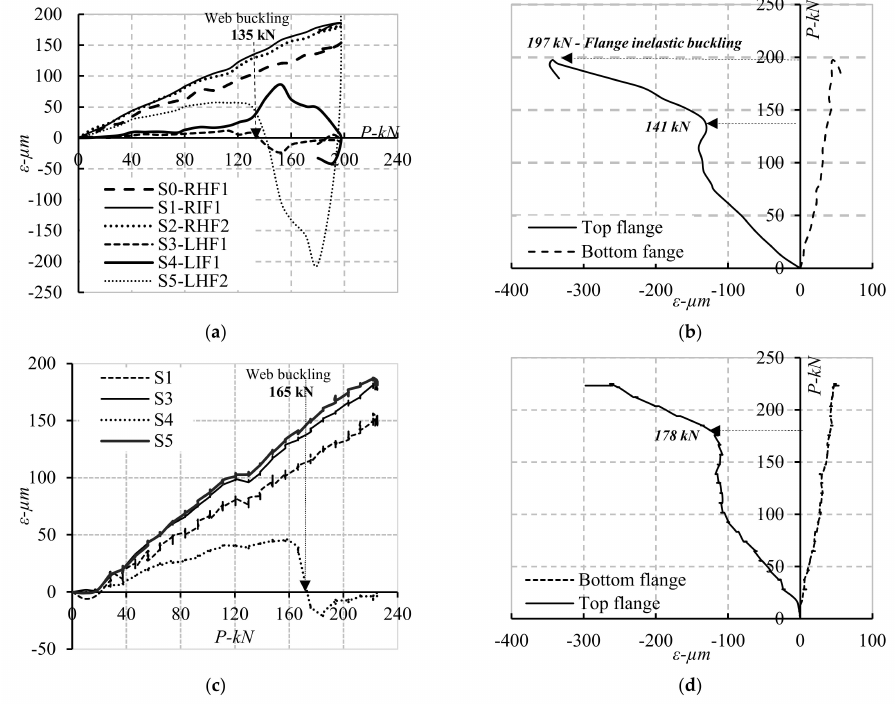
Figure 13. Strain development in the Horizontal and inclined web folds and top and bottom flanges; ( a ) CW20IFNW Web-HZ and IN folds; ( b ) CW20IFNW-Top and bottom flanges; ( c ) CW20IFNWFS Web-HZ and IN folds; ( d ) CW20IFNWFS-Top and Bottom